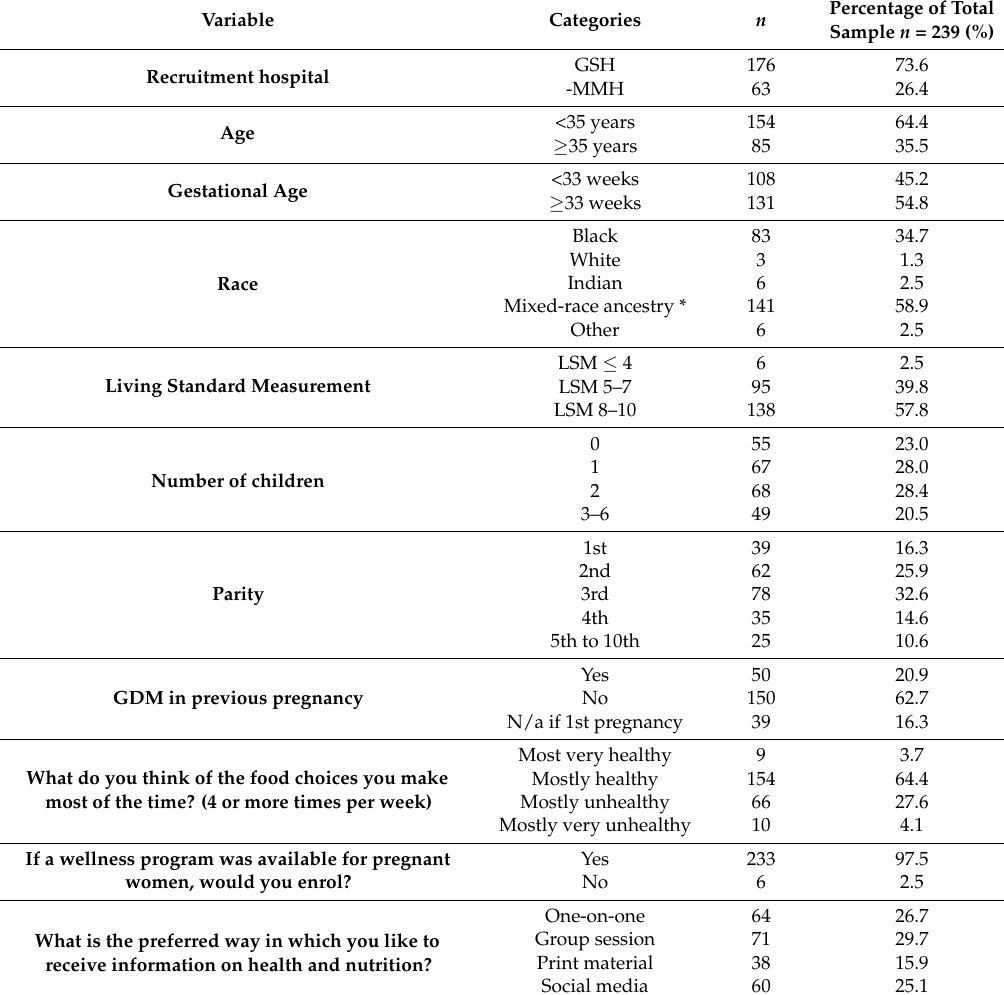
Table 2. Sociodemographic profile and pregnancy history of sample ( n =